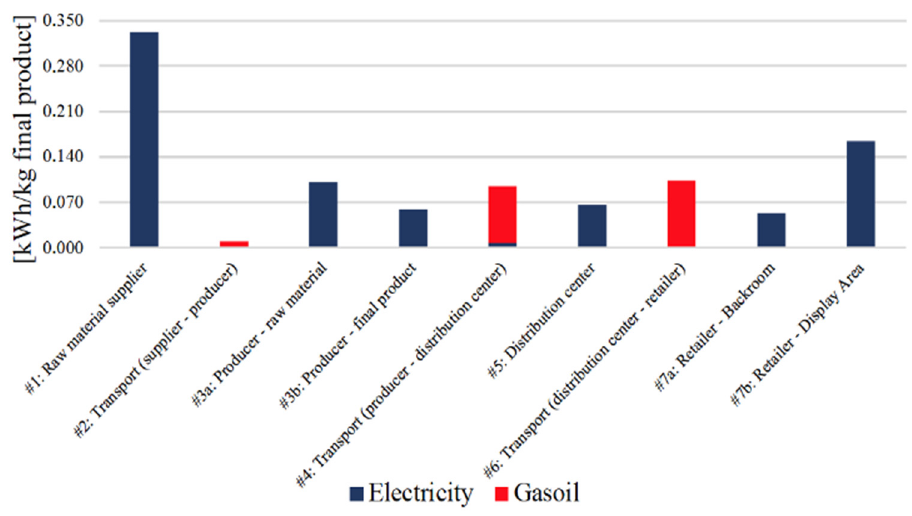
Figure 2. Specific energy consumption for each energy carrier and each actor of the cold chain.